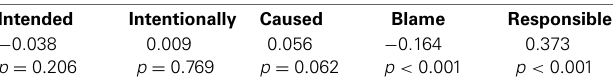
Table 2 | Partial correlations of the five factors with moral rightness